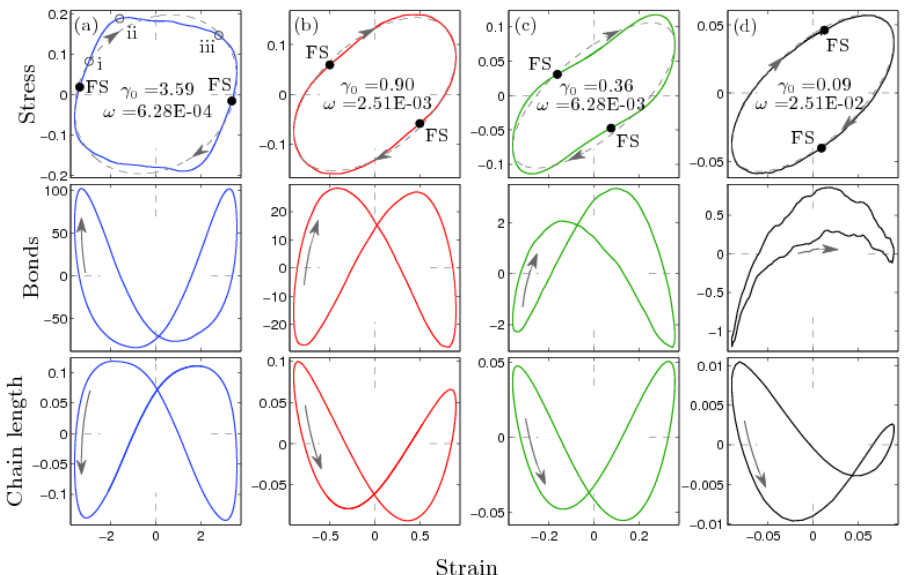
Figure 3. Lissajous trajectory curves are shown for four different frequency ω and amplitude γ 0 combinations. Columns ( a ) through ( d ) contain data at the frequency and strain amplitude values reported within the center of each pane. The top row shows the stress-strain relationship. The stress σ as a function of the strain γ is shown as a colored line, with the linear contribution to these data shown as a dashed gray line. The middle row shows the strain dependence of the number of bonds. The average end-to-end chain length is shown in the bottom row. All data are averaged over multiple periods of oscillation. Arrows indicate the direction of the given trajectory in time. FS is the most favorable state, the one at which the number of temporary bond peaks and the chain length reaches a minimum.